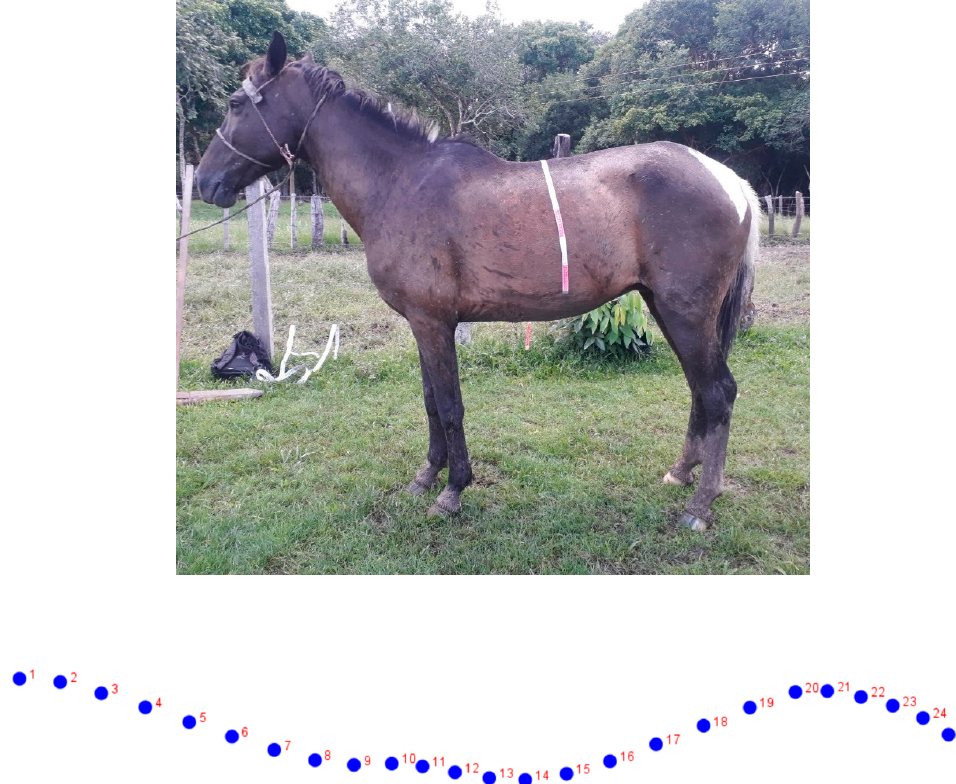
Figure 1. Semi-landmarks used for the study. A set of 25 reference points (semi-landmarks) in each image were digitized at the dorsal level of the neck (10 semi-landmarks), back (10 semi-landmarks), and croup (5 semi-landmarks).